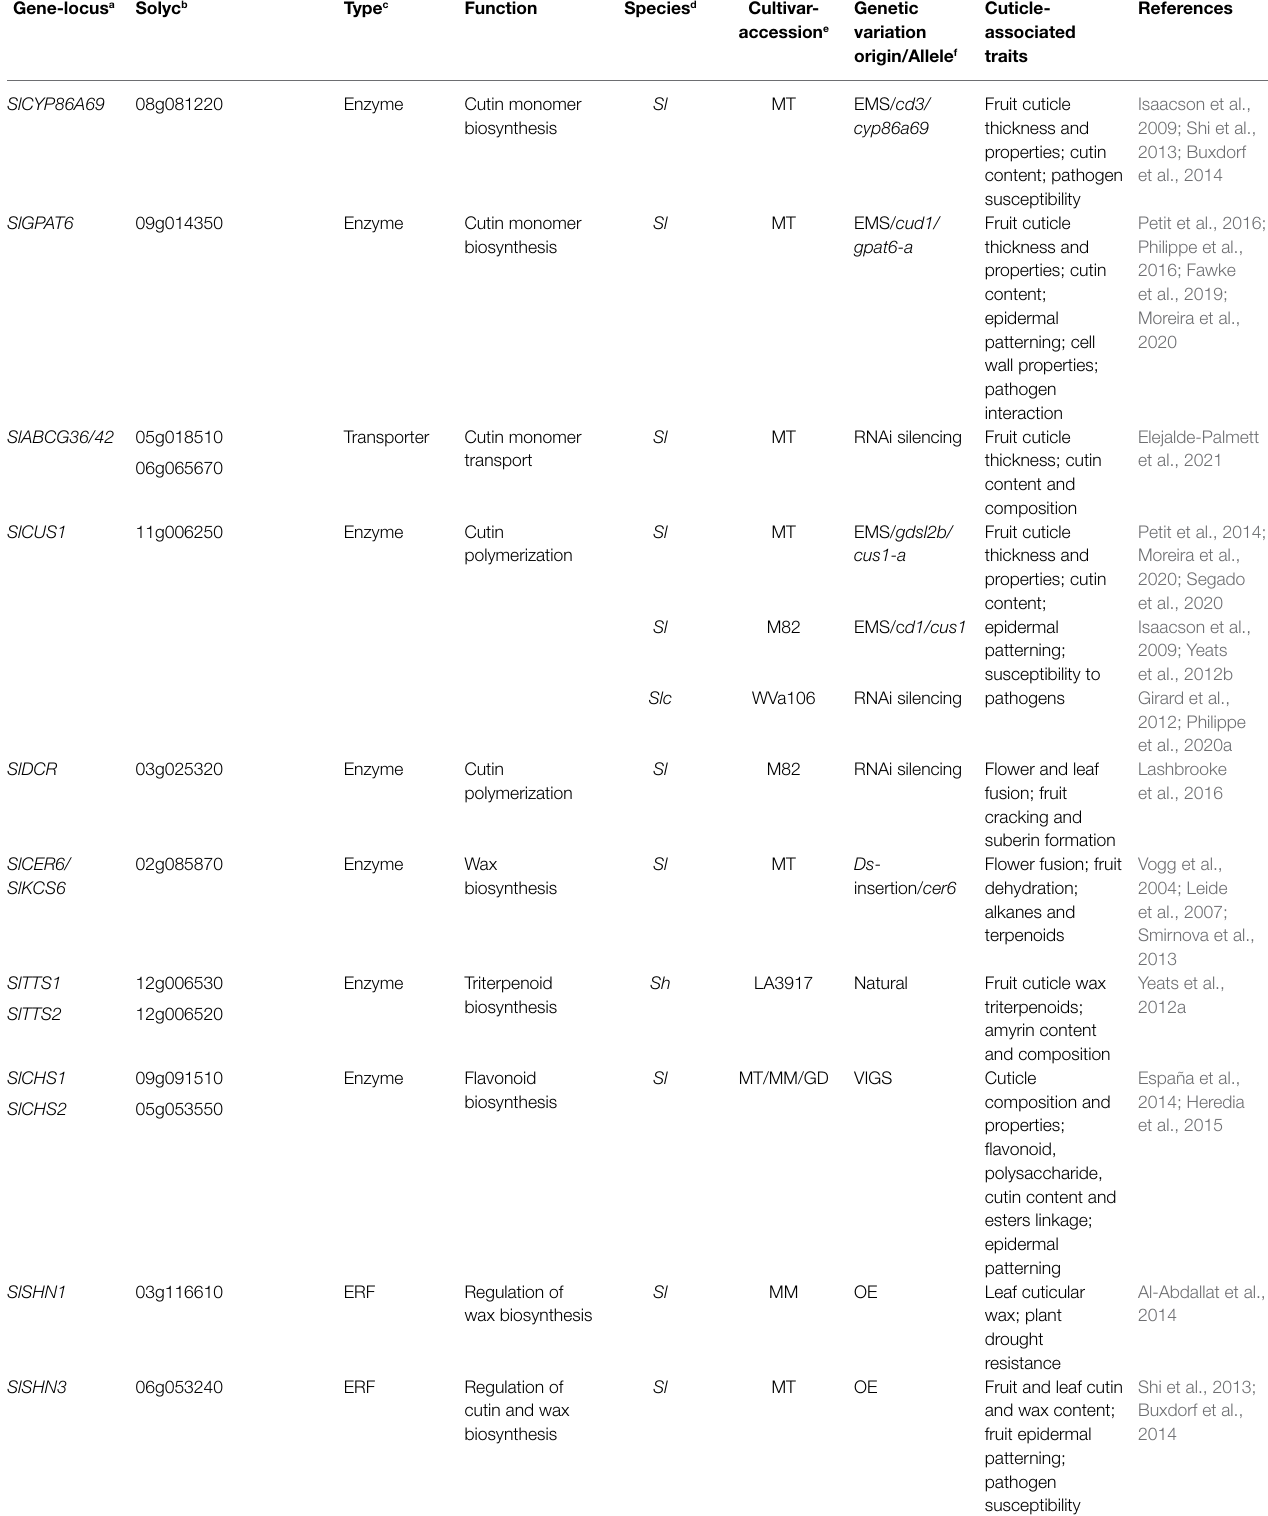
TABLE 1 | Genes involved in cuticle formation and properties studied in tomato. * Gene-locus a Solyc